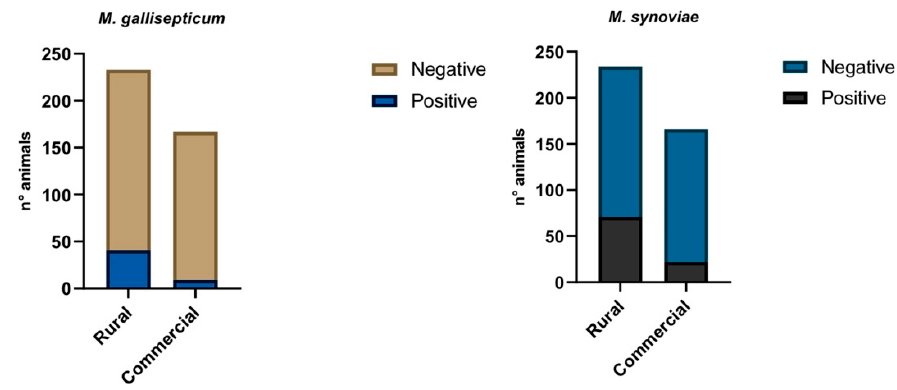
Figure 3. Molecular results obtained by duplex real time PCR to evaluate the presence of MS and